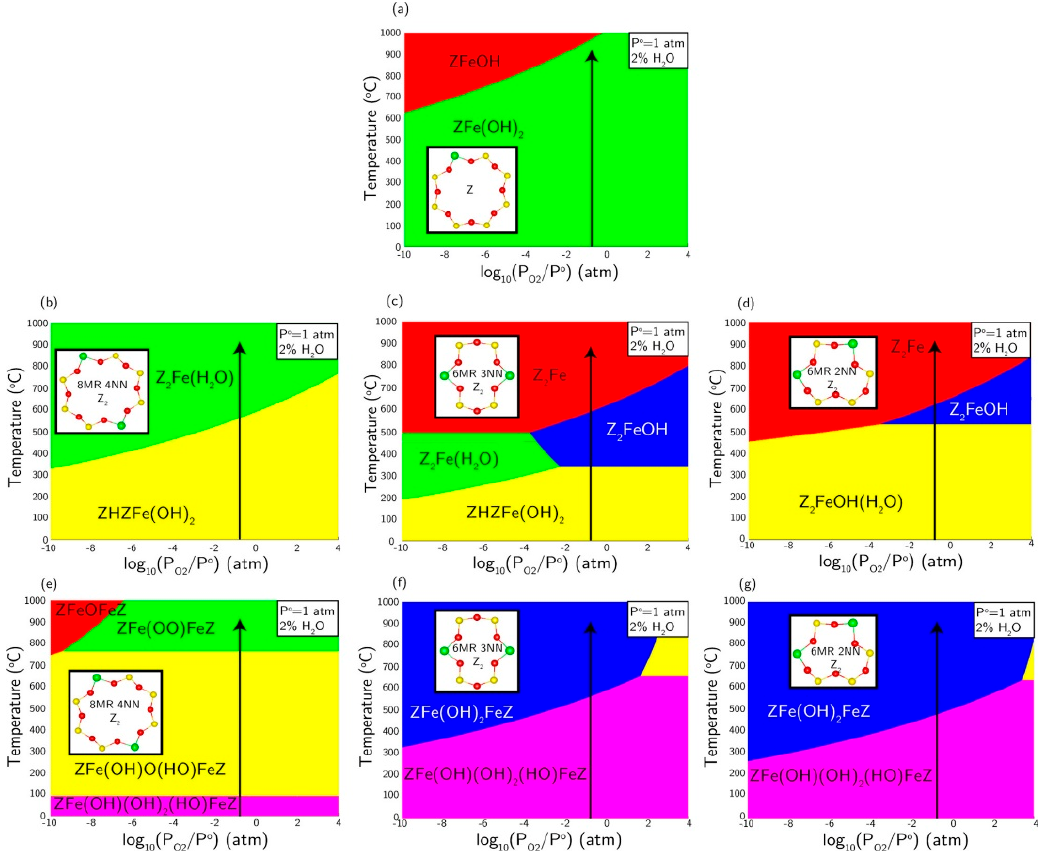
Figure 10. Compositional Fe-site phase diagrams vs relative O 2 pressure and temperature at 0.02 atm of H 2 O. ( a – d ) Monomeric Fe at isolated Al, 8MR 4NN, 6MR 3NN, and 6MR 2NN Z 2 sites, respectively, and ( e – g ) dimeric Fe species. Black vertical arrows correspond to PO 2 = 0.2 atm. Reprinted with permission from [35]. Copyright © 2018 American Chemical Society.